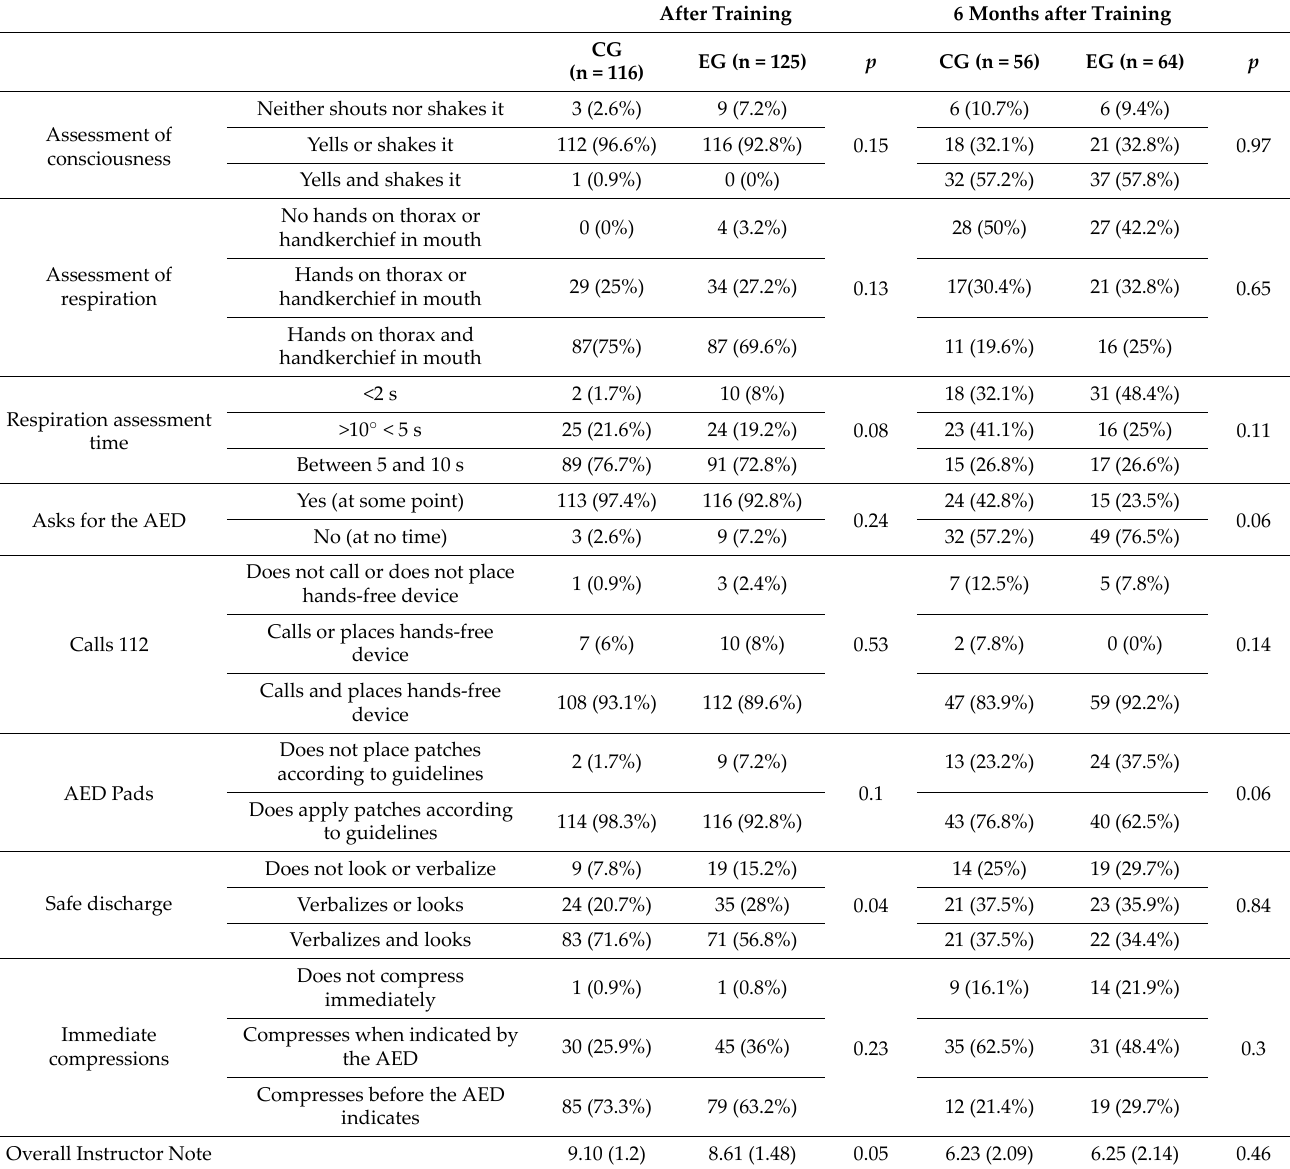
Table 4. Values obtained from the practical evaluation by the